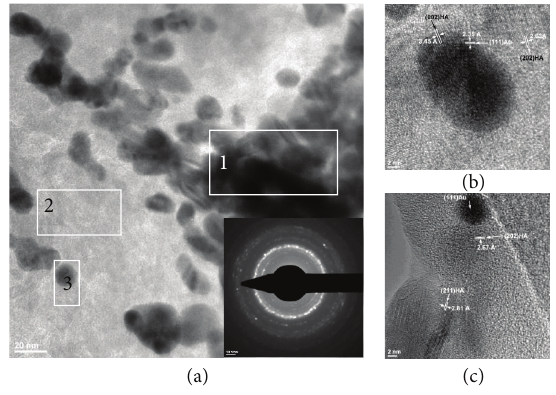
Figure 11: TEM micrographs providing morphostructural evi- dences on the formation of HA on the Au-G6-1 functionalized PHEMA surface; HA nanocrystals are formed around agglomer- ations of gold-dendrimer nanocomposites; (a) agglomerations of nanocomposites (area 1) are embedded in a mass of HA (area 2) formed following the incubation in SBF1.5x, while area 3 presents one nanocomposite particle with HA nanocrystals around and the inset 4 represents the SAED image with crystallographic planes characteristic to Au and HA; (b), (c) HR-TEM images presenting one nanocomposite nanoparticles identified through the typical crystallographic planes (111) surrounded by HA nanocrystals with their characteristic planes (002), (202), and